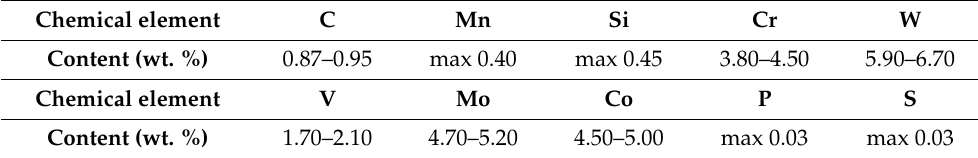
Table 1. Chemical composition of the substrate HS6-5-2-5 EN ISO 4957. Chemical